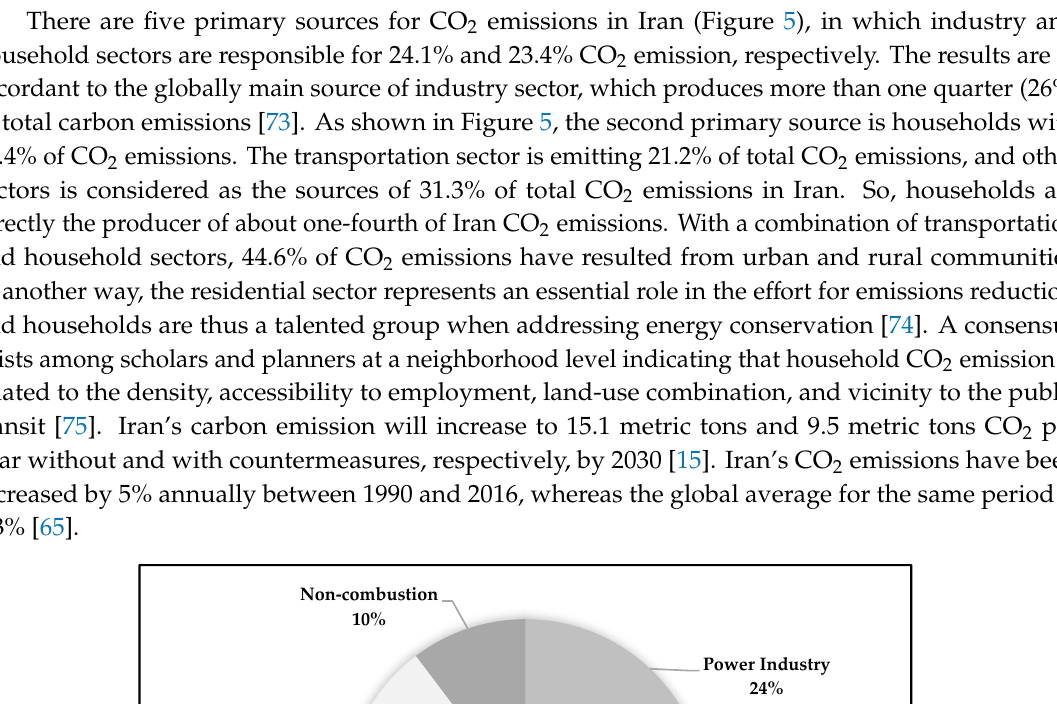
Figure 4. Per capita CO 2 emissions in Iran, modified from [63].